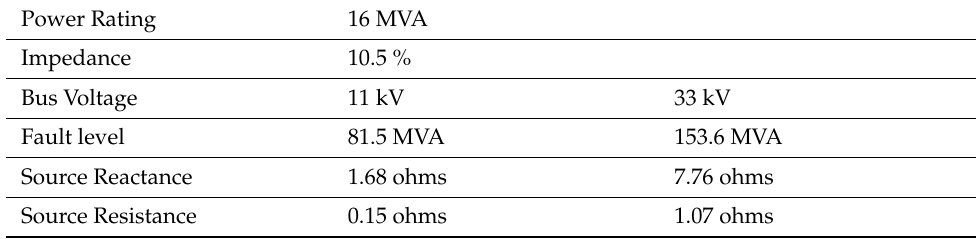
Table 2. 33 kV/11 kV Transformer